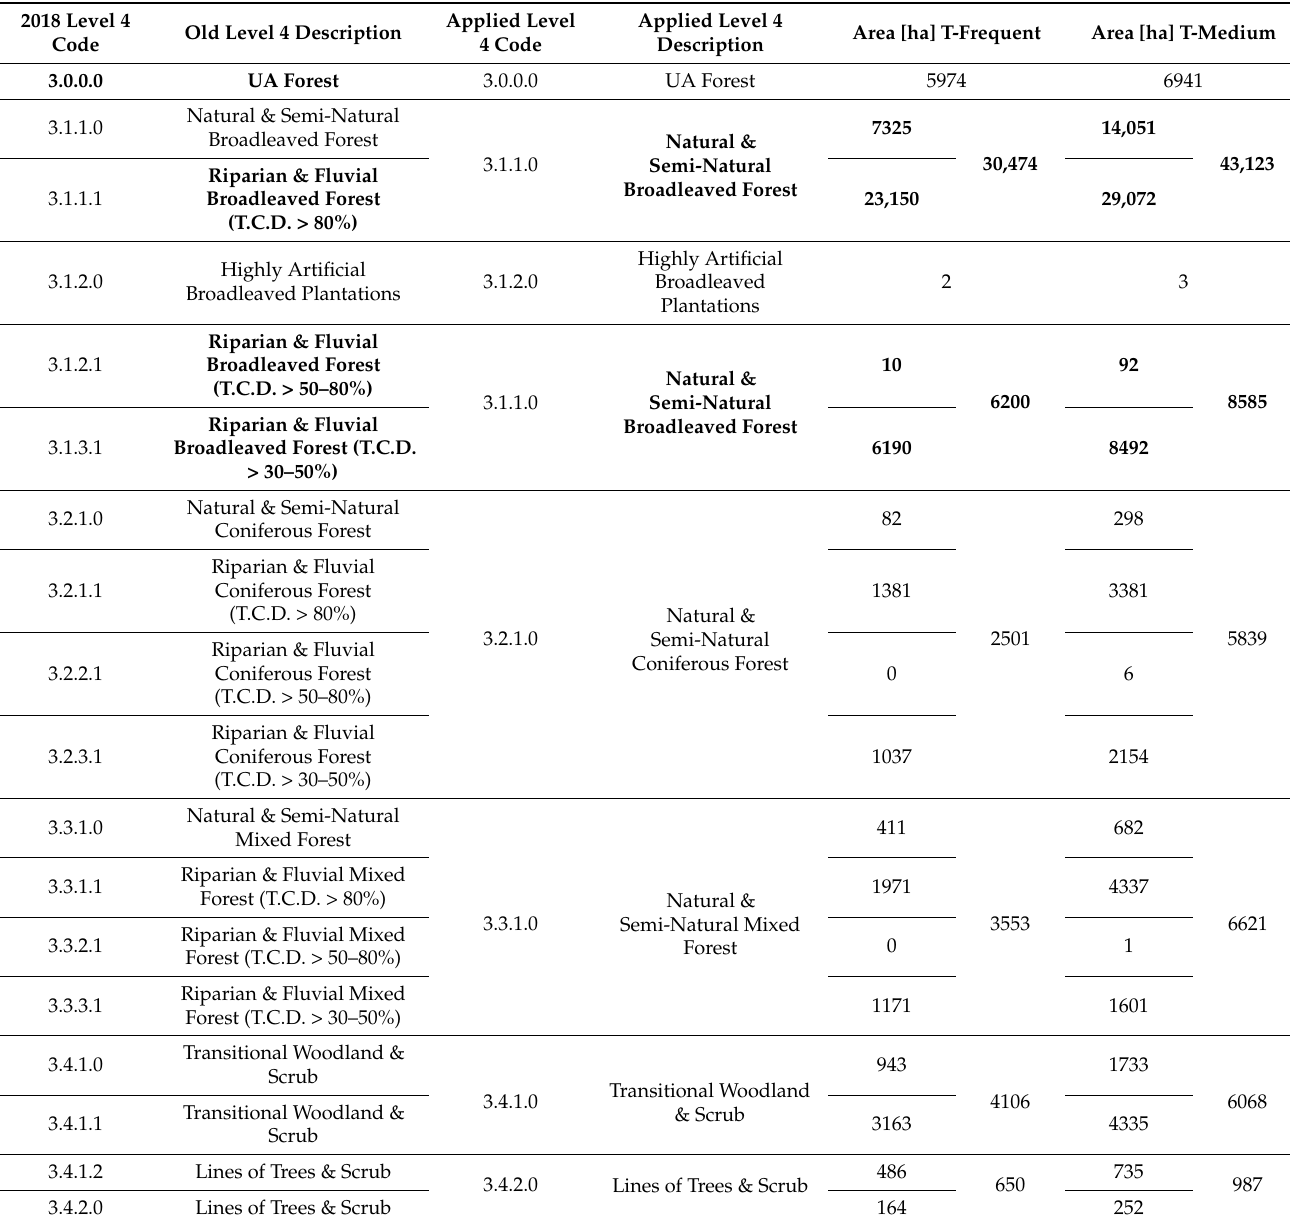
Table 5. Comparison of different forest nomenclature of the Copernicus land use riparian zones dataset applied in different river basins and their respective area calculated for T-frequent and T-medium floodplains. Aggregation was carried out mainly in the category of tree canopy density (TCD). Areas of identified riparian floodplains are in